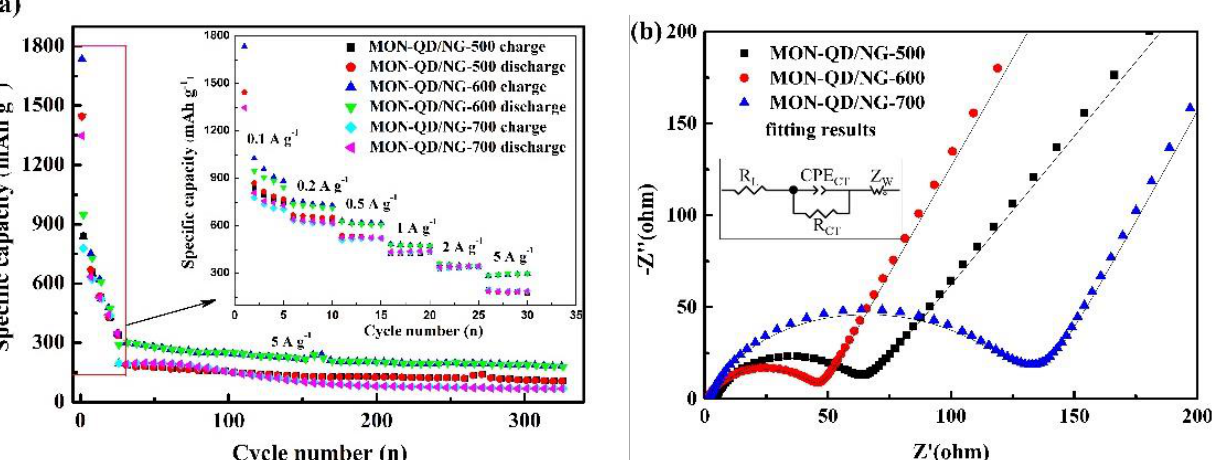
Figure 8. Electrochemical performance of electrode materials at different calcination temperatures: